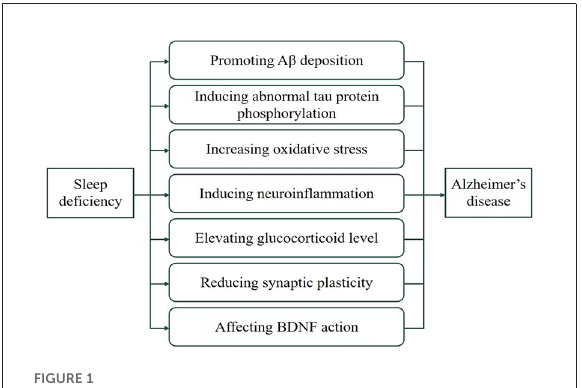
FIGURE1 Mechanism summary of sleep deficiency and